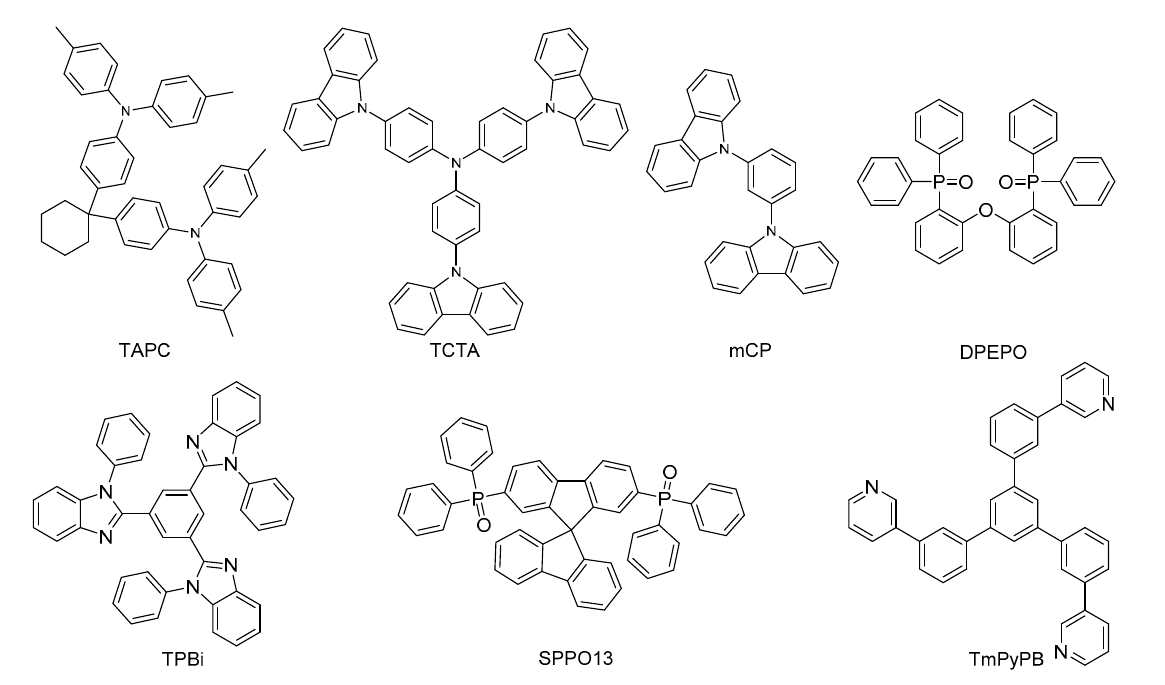
Figure 2. The calculated HOMO and LUMO distributions of DTF and molecular structure of mate- rials used in devices.